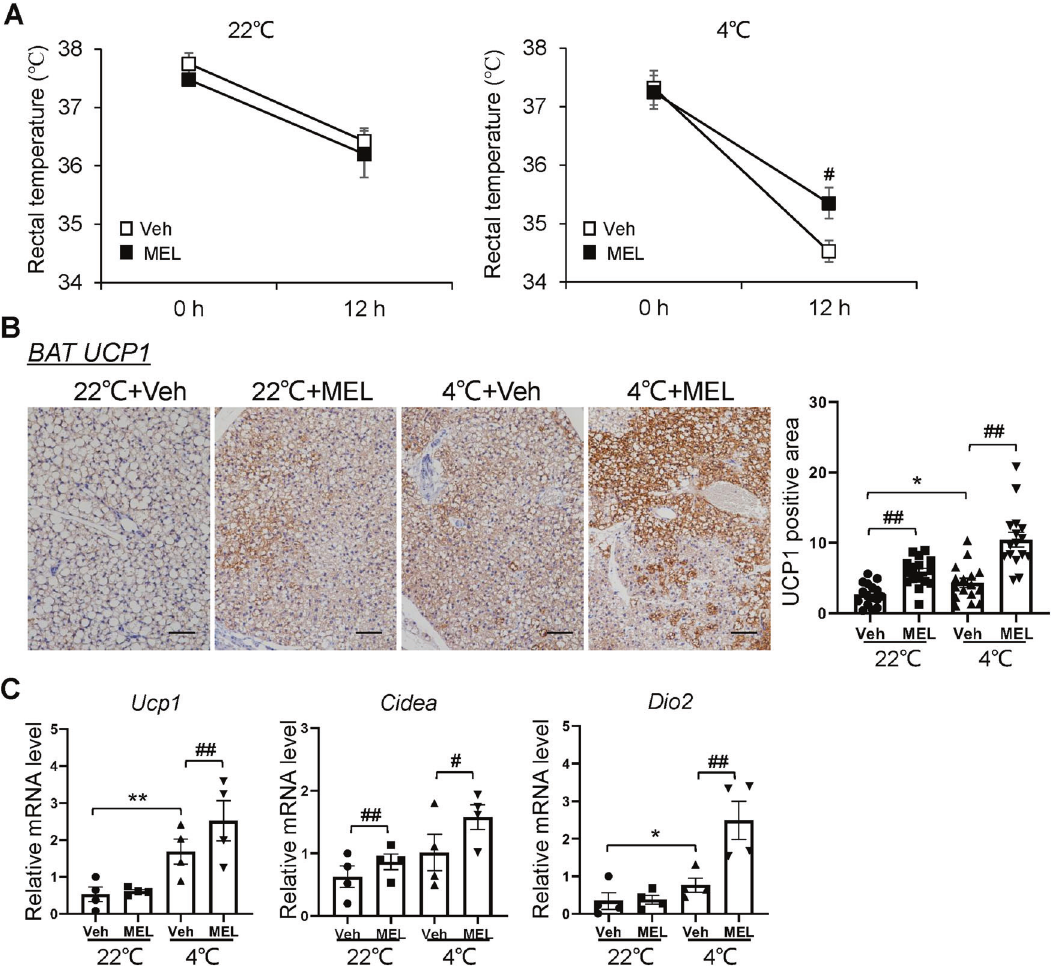
Fig. 4 Melatonin increases adaptive thermogenesis of cold-stimulated mice. A Rectal temperature of 22 °C- and 4 °C-stimulated mice. B UCP1-stained BAT section of 22 °C- and 4 °C-stimulated mice. C mRNA expression of thermogenesis-related genes in BAT of mice. Data are mean ± SEM, n = 4. Signi fi cance was determined by one-way ANOVA. *p < 0.05, **p < 0.01 vs. 22 °C + Veh mice; # p < 0.05, ## p < 0.01, vs. 4 °C + Veh